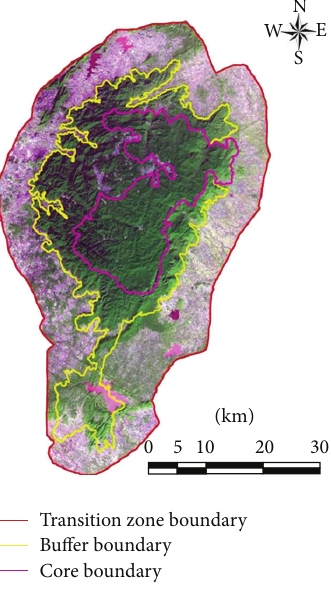
Figure 1: Natural colour composition of the SBR along with core, buffer, and transition boundaries.